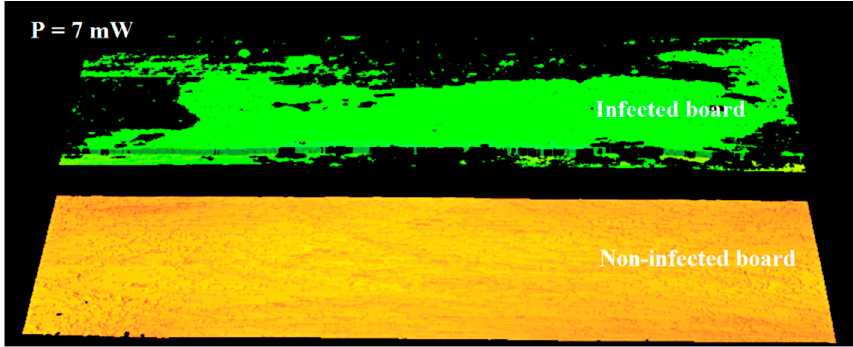
Figure 8. Three ‐ dimensional image of a surface acquired using 7 mW power.